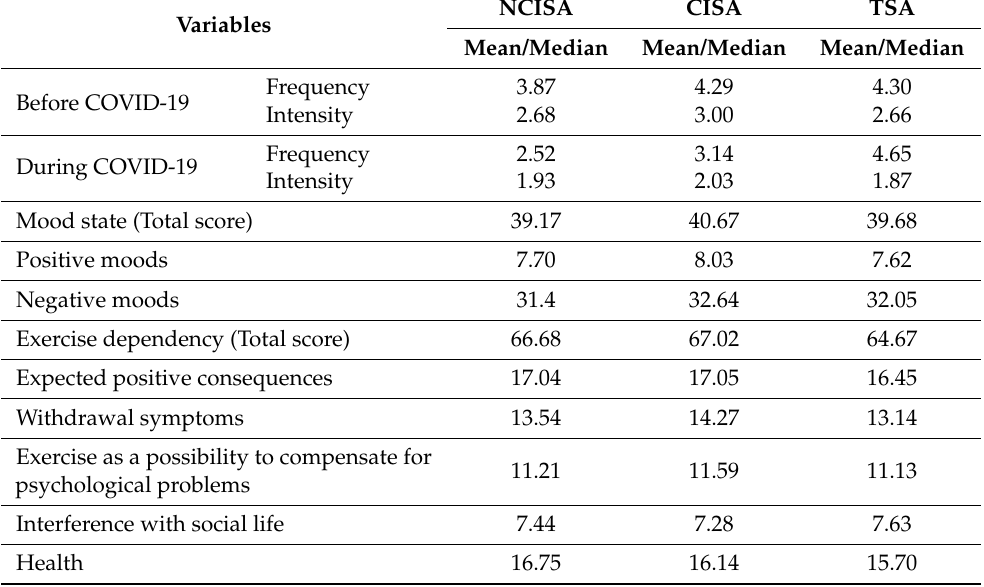
Table 1. Descriptive statistics of studied